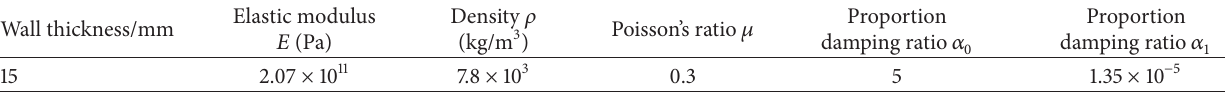
Table 3: Parameters of casings.